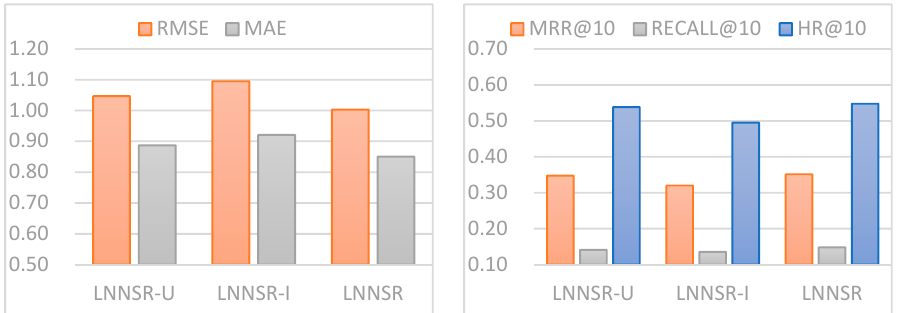
Figure 6. Effect of user’s attribute information and item’s attribute information on the Book-Crossing dataset.